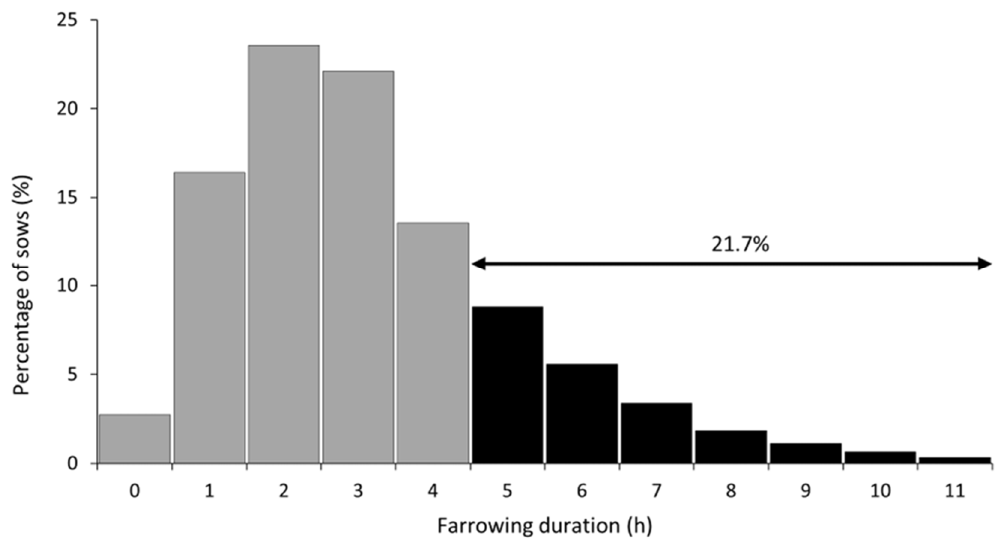
Figure 1. Frequency distribution of sows based on farrowing duration ( n = 2493). Table 2. Pearson’s correlations between farrowing duration (mean ± SD = 221.0 ± 119.3 min), birth interval (mean ± SD = 16.6 ± 9.4 min) and sow reproductive characteristics ( n = 2493).